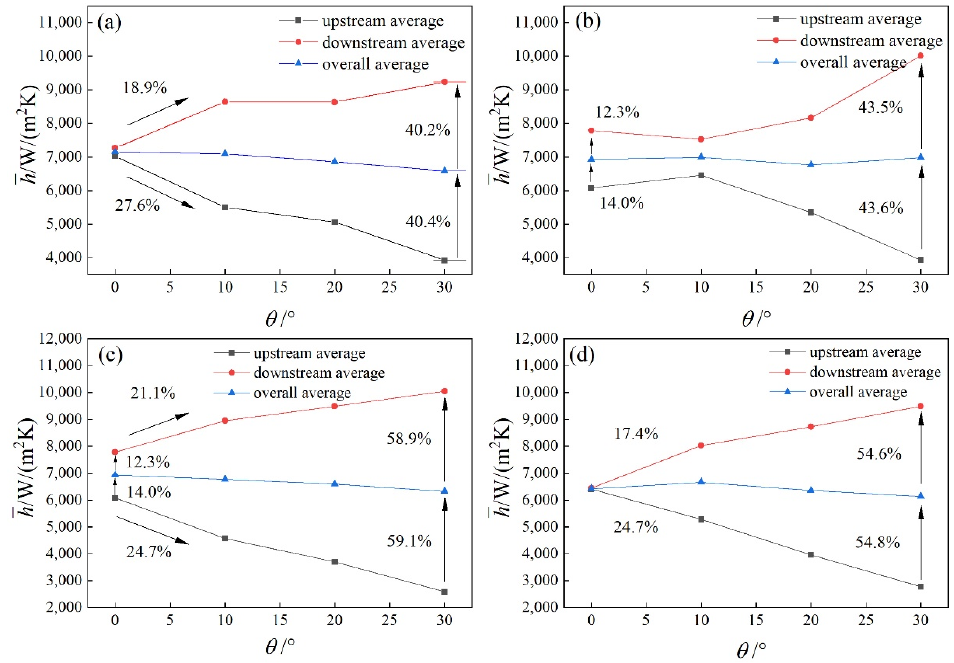
Figure 7. Comparison of the average heat transfer coefficient ( h ) between the downstream region and upstream region under different tilt angles ( θ ). ( a ) Top jet; ( b ) right jet; ( c ) left jet; ( d ) bottom jet.